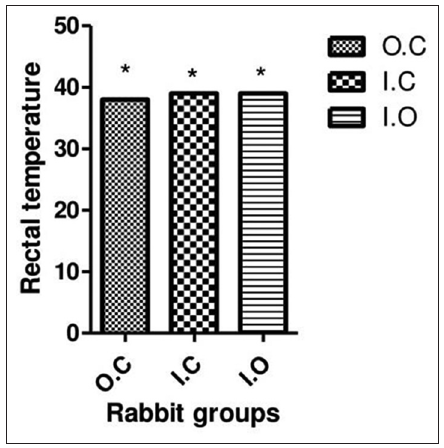
Figure-2: Group (G) overall body temperature changes throughout 10 weeks of the trial period. Data are expressed as mean±SD. The values with single star represent no significant difference (p=0.05) among groups. OC=Outdoor control group, IC=Indoor cages, IO=Indoor